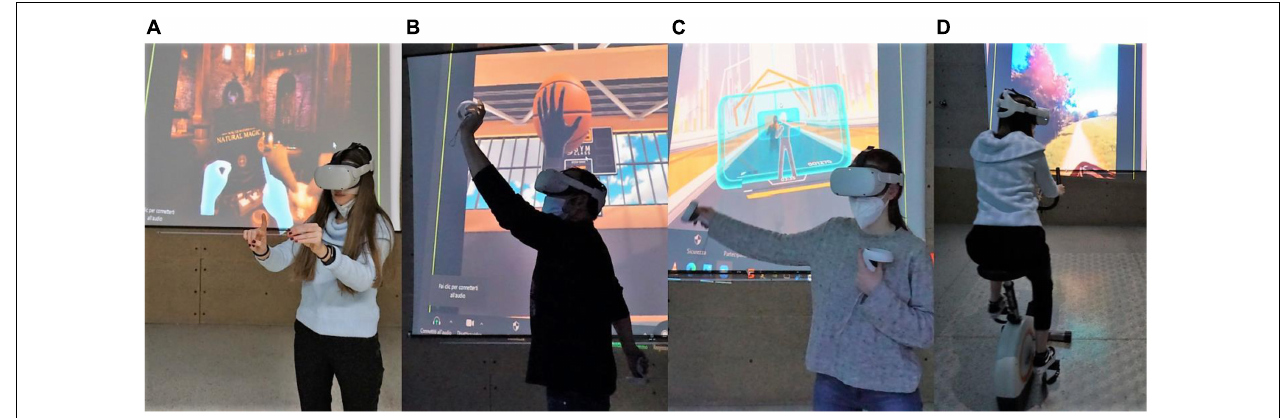
FIGURE 1 | (from left to right): Users wearing HMDs and interacting with commercially available applications through their actual hands (A) , controllers in their hands’ place and their virtual hand-like representation (B) , their whole body as represented by a virtual full-body shadow (C) or external movement platforms (i.e., bicycle) (D)